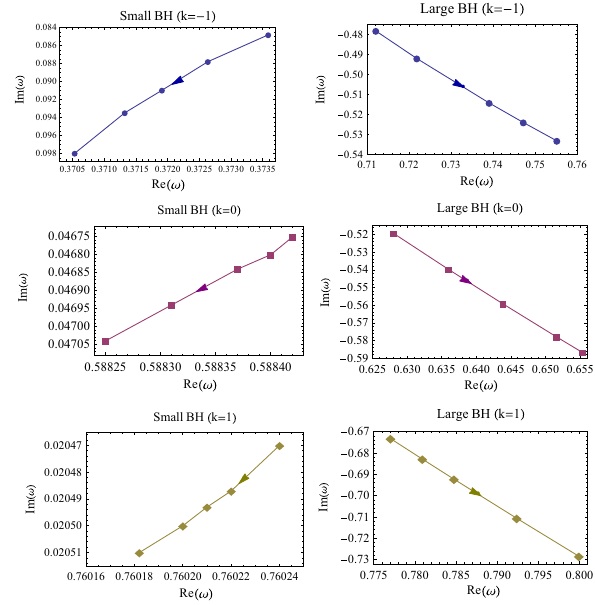
Fig. 2 The behavior of QNM frequencies for large and small black holes in the isobaric process. The arrow indicates the increase of the black hole